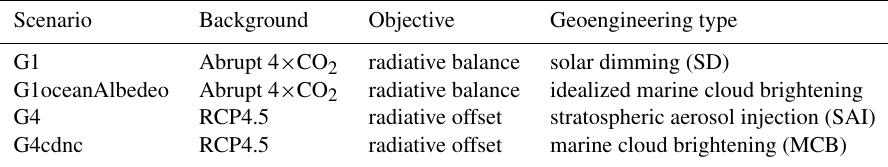
Table 2. A summary of the four experiments included in this